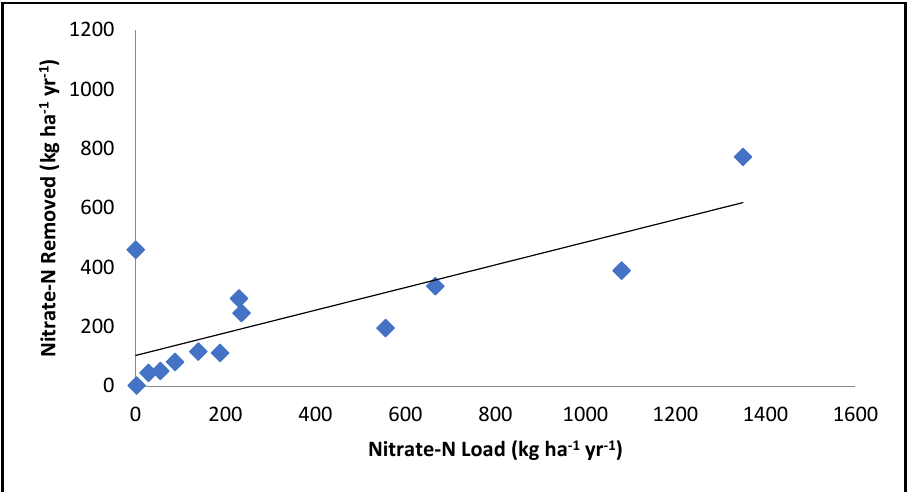
Table 2. Percent removal of nutrients in floodplains. Percent reductions in nitrate-N (NO 3− -N) and total or particulate phosphorus (TP or particulate P) loads in floodplains from literature reviewed.